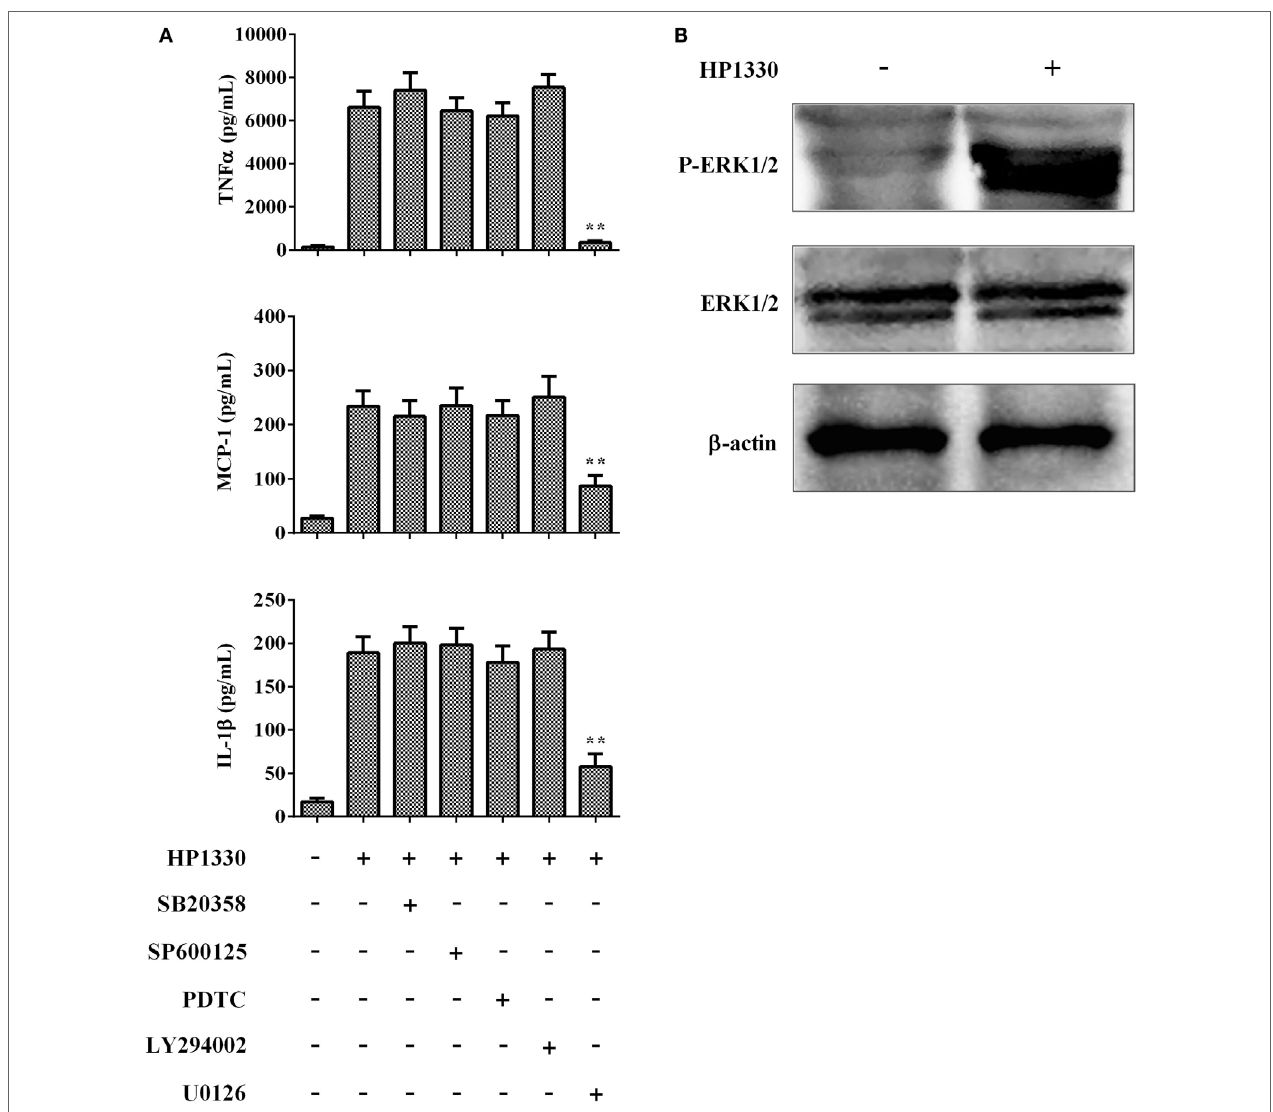
FigUre 9 | Signal-transduction pathways of the HP1330-stimulated, pro-inflammatory response in RAW 264.7 macrophages. (a) After pretreatment with inhibitors of p38 MAPK (SB203580), JNK (SP600125), NF- κ B (PDTC), PI3K (LY294002), or ERK1/2 (U0126) for 30 min, RAW 264.7 macrophages were stimulated with 10 µg ⋅ ml − 1 HP1330 for 6 h. The cytokine levels were then determined by enzyme-linked immunosorbent assay. Data are expressed as the mean ± SD of three independent experiments. ** P < 0.01. (b) HP1330-induced phosphorylation of ERK 1/2 MAPK in RAW264.7 macrophages. RAW264.7 macrophages were stimulated with HP1330 (10 µg ⋅ ml − 1 ) for 6 h. The cell lysates were analyzed by western blotting using specific antibodies against ERK 1/2 MAPK and phospho- ERK 1/2 MAPK. β -Actin was detected as an internal control using an anti- β -actin antibody. The results shown are representative of three independent